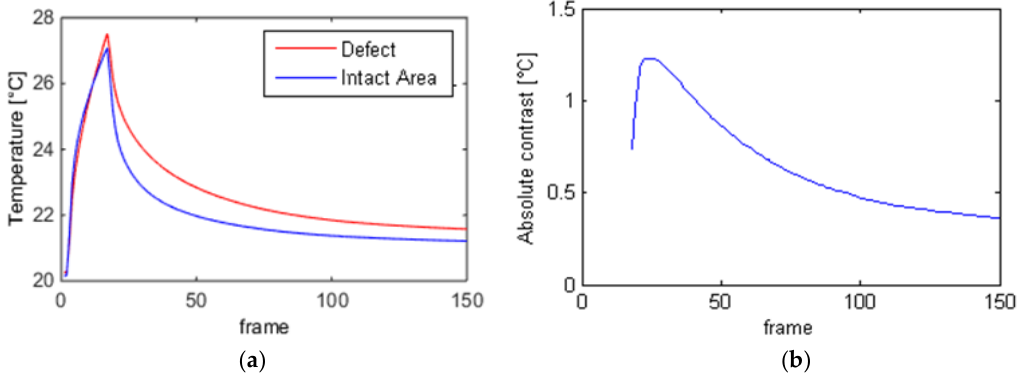
Figure 10. ( a ) Thermal profiles on multi-stringer component on left side of impact and ( b ) absolute contrast curve for delaminations with respect to intact area, using heating time of 7 s.